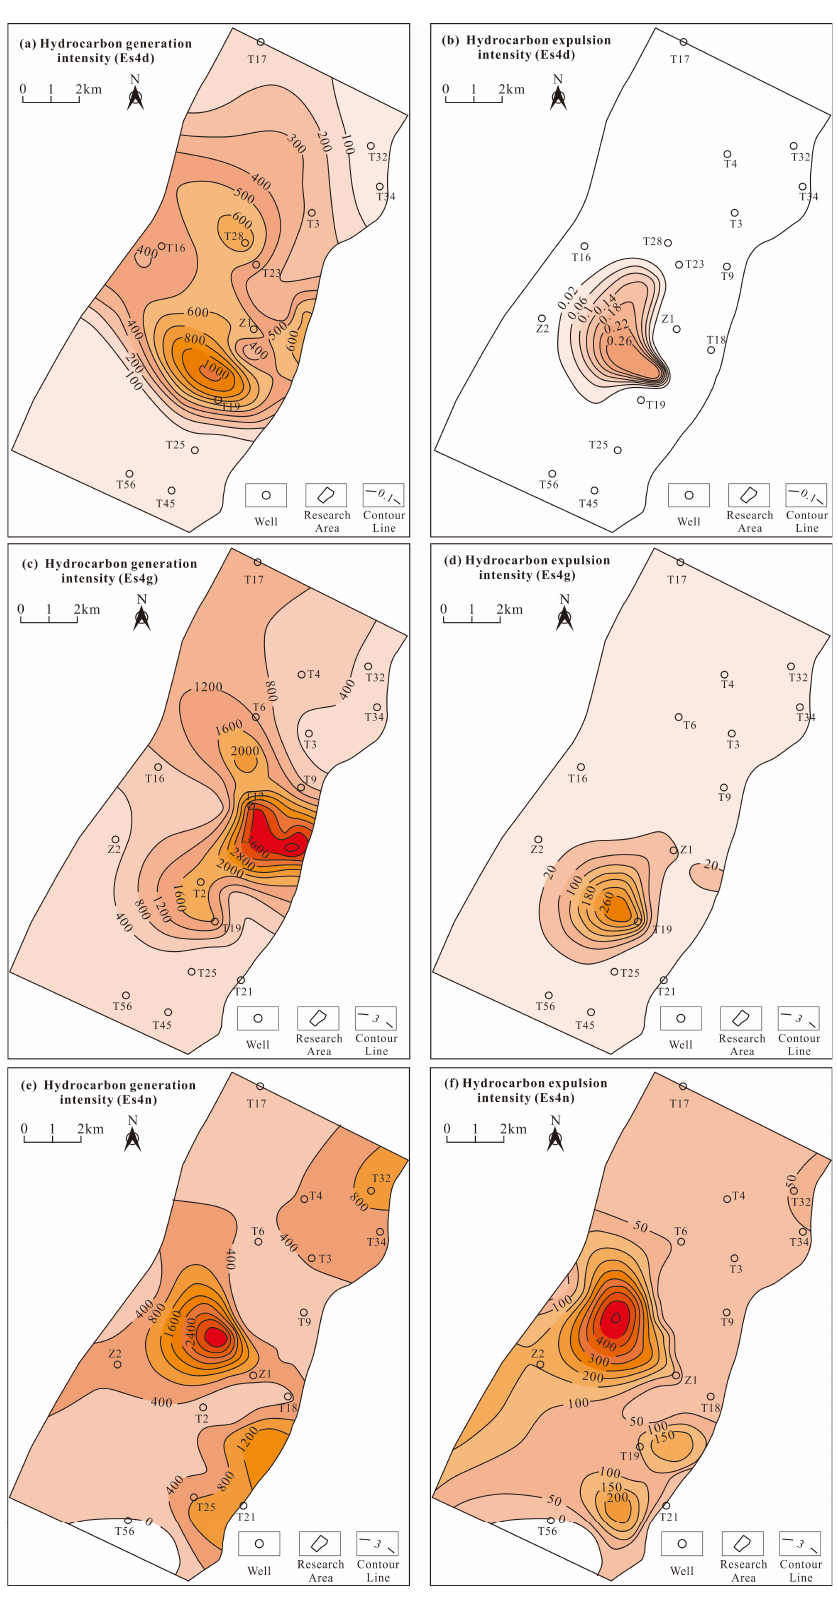
Figure 16. The I g and I e distributions of the Es4 source rocks in the Niuxintuo area. ( a ) I g of the Es4d source rocks; ( b ) I e of the Es4d source rocks; ( c ) I g of the Es4g source rocks; ( d ) I e of the Es4g source rocks; ( e ) I g of the Es4n source rocks; ( f ) I e of the Es4n source rocks.